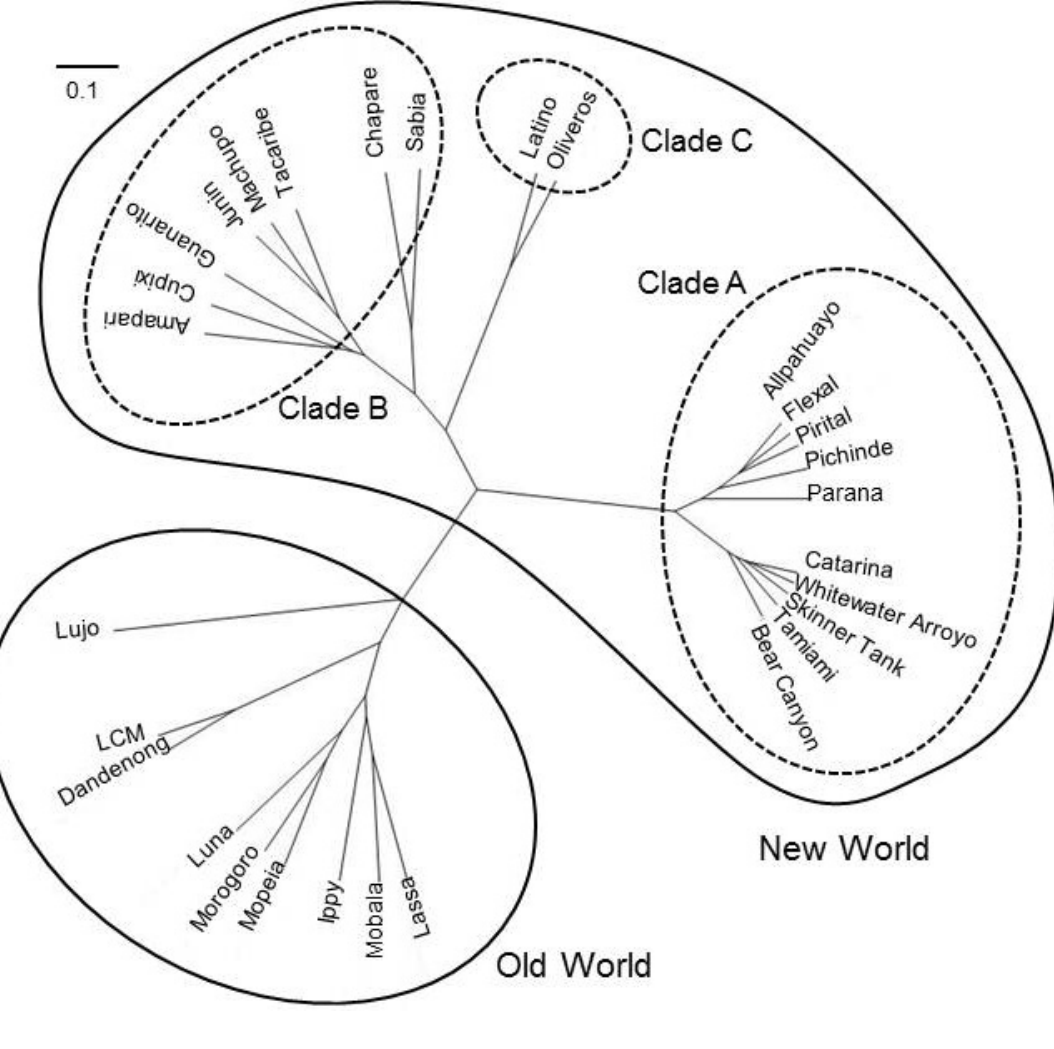
Figure 1. Phylogenetic tree of arenavirus Z protein. Amino acid sequences of Z protein were used for analysis. The phylogenetic tree was drawn using GENETYX [1]. The scale bar indicates substitutions per site. Accession numbers for reference sequences